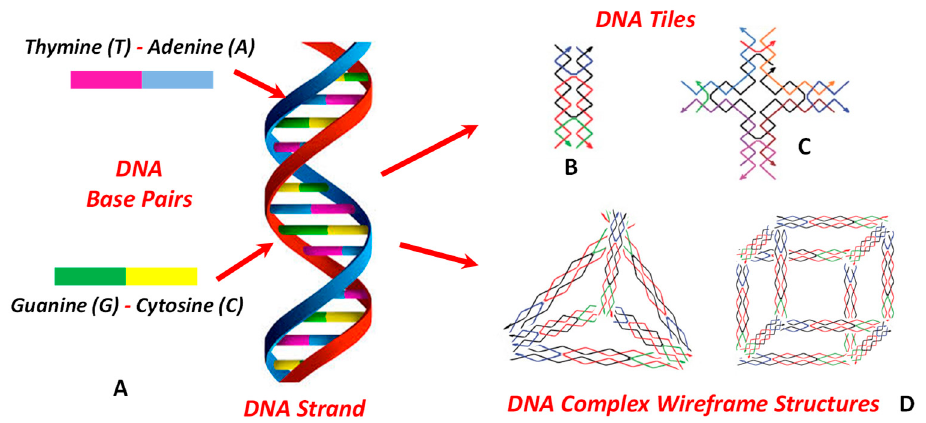
Figure 15. SchematicdrawingsofbasepaircompositionandstructureoftheDNAstrand(doublehelix)( A ). Structure and morphology of the generated DNA complexes (DNA double crossover (DX) tile ( B ), 4 × 4 tile ( C ) and complex wireframe structure ( D )). Colored lines represent di ff erent oligonucleotide strands with